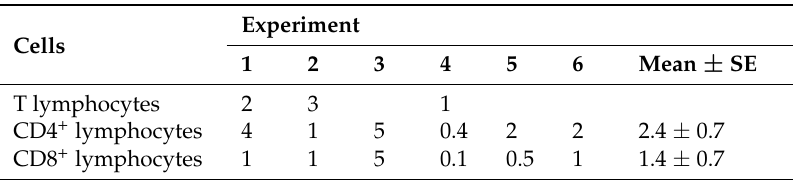
Table 2. Percent of influenza virus-infected T lymphocytes or lymphocyte subpopulations serving as infectious foci for MDCK cells.